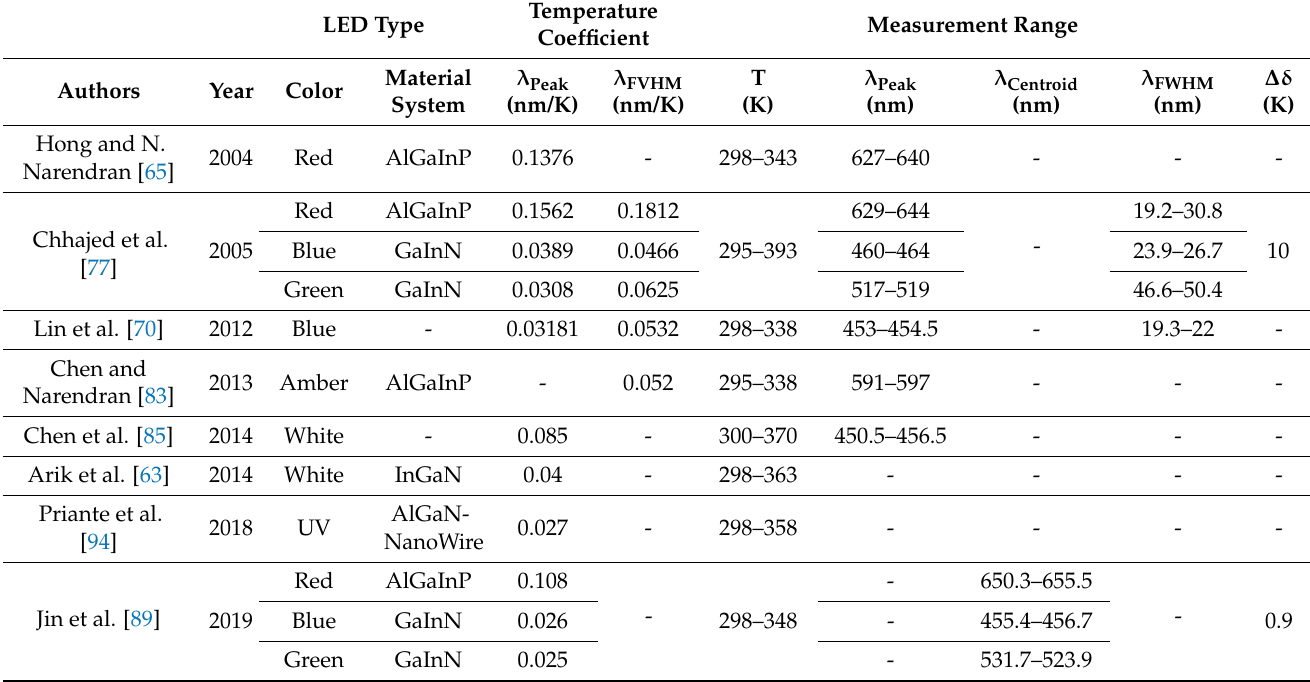
Table 1. TSOP-based experimental temperature measurement parameters that are employed in the literature for the thermal characterization of LEDs. References are sorted by year. Not reported parameters are indicated by a hyphen in the table. ( ∆ δ : uncertainty, λ :